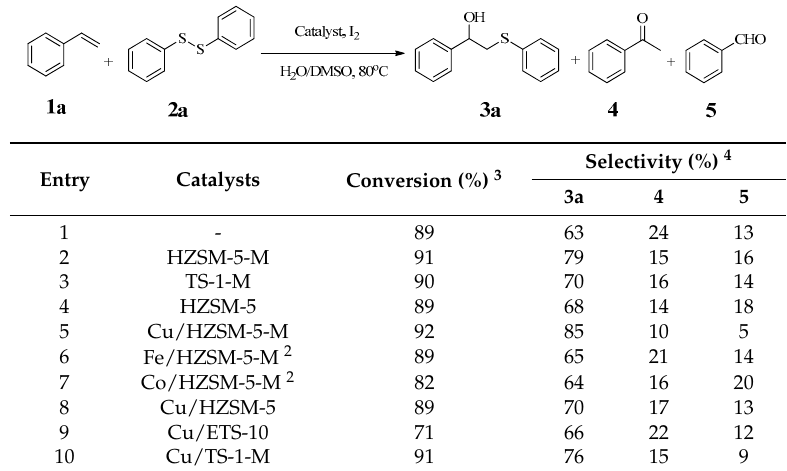
Table 2. Hydroxysulfurization reaction over different catalysts 1 .